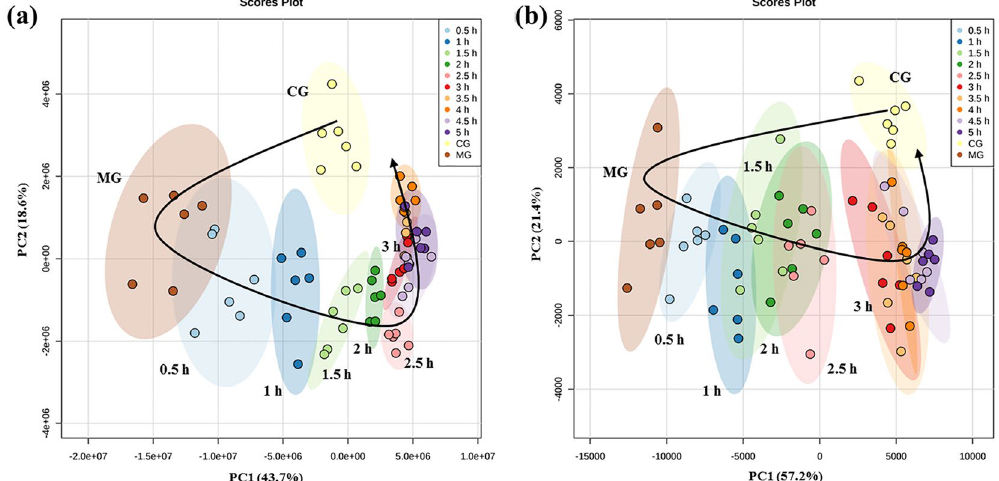
Figure 3. PCA scores plot among CG, MG, and TG rats at different sampling time points. The plot showed a time dependent trajectory of hypothalamus metabolites which clustered at different spatial positions. ( a ) At positive ion mode. ( b ) At negative ion